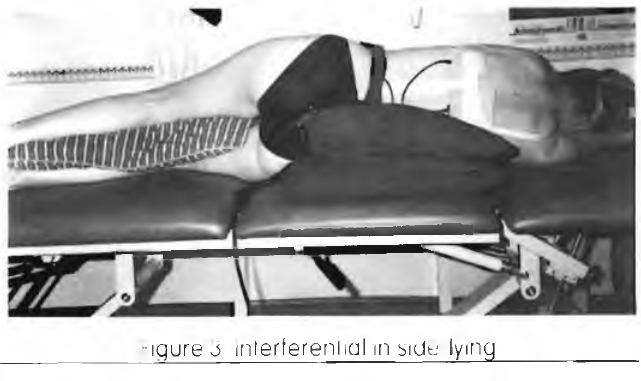
figure 2 Lett s.de tlex.cn pain. Left side flexion produced 5/5 pain when the fingertips reached half wav down the thigh (0,25 of the range) (Figure